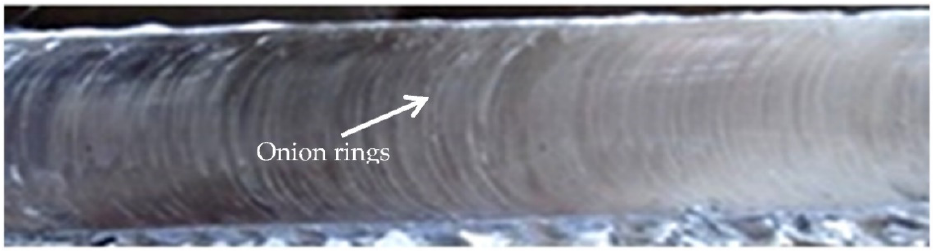
Figure 8. Surface profile of AZ31 and AA6061 and AZ91 and AZ31B in the SZ region.